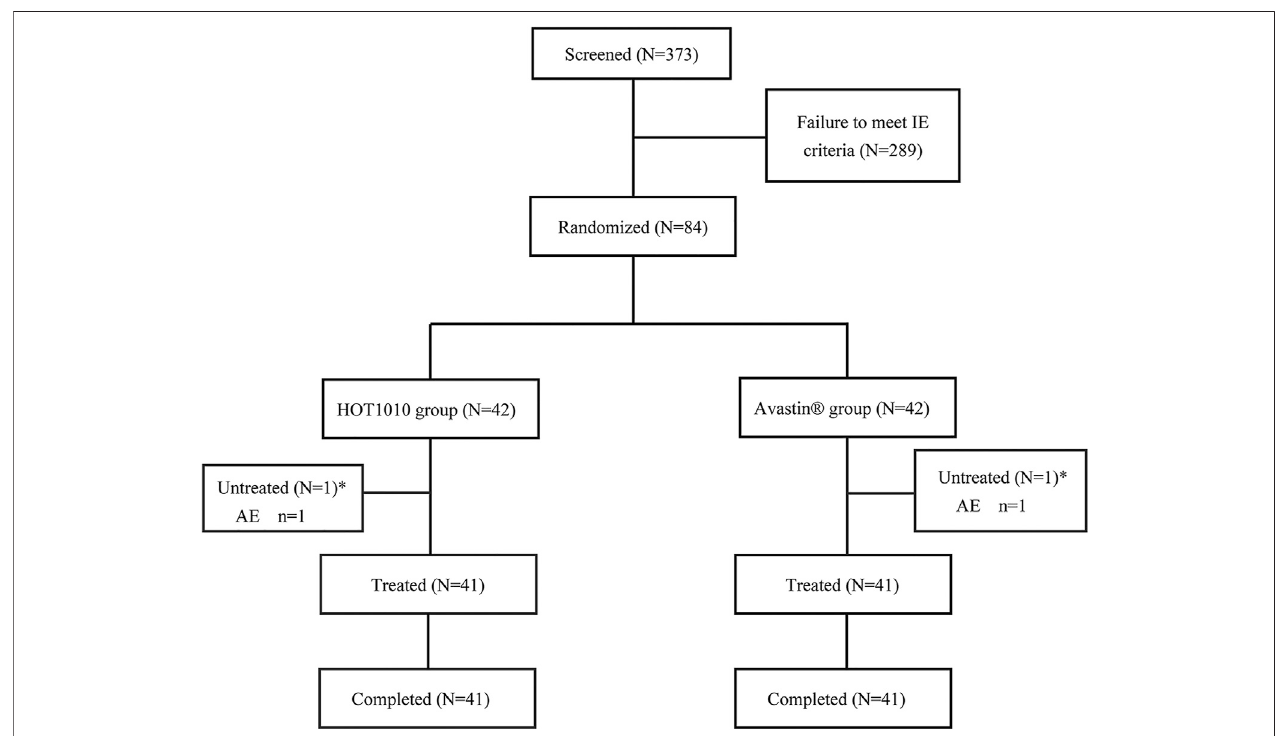
FIGURE 1 | Subjects dispositions for HOT-1010 group vs. bevacizumab group. *Mild abnormality in ECG was found before dosing. IE: inclusion/exclusion.